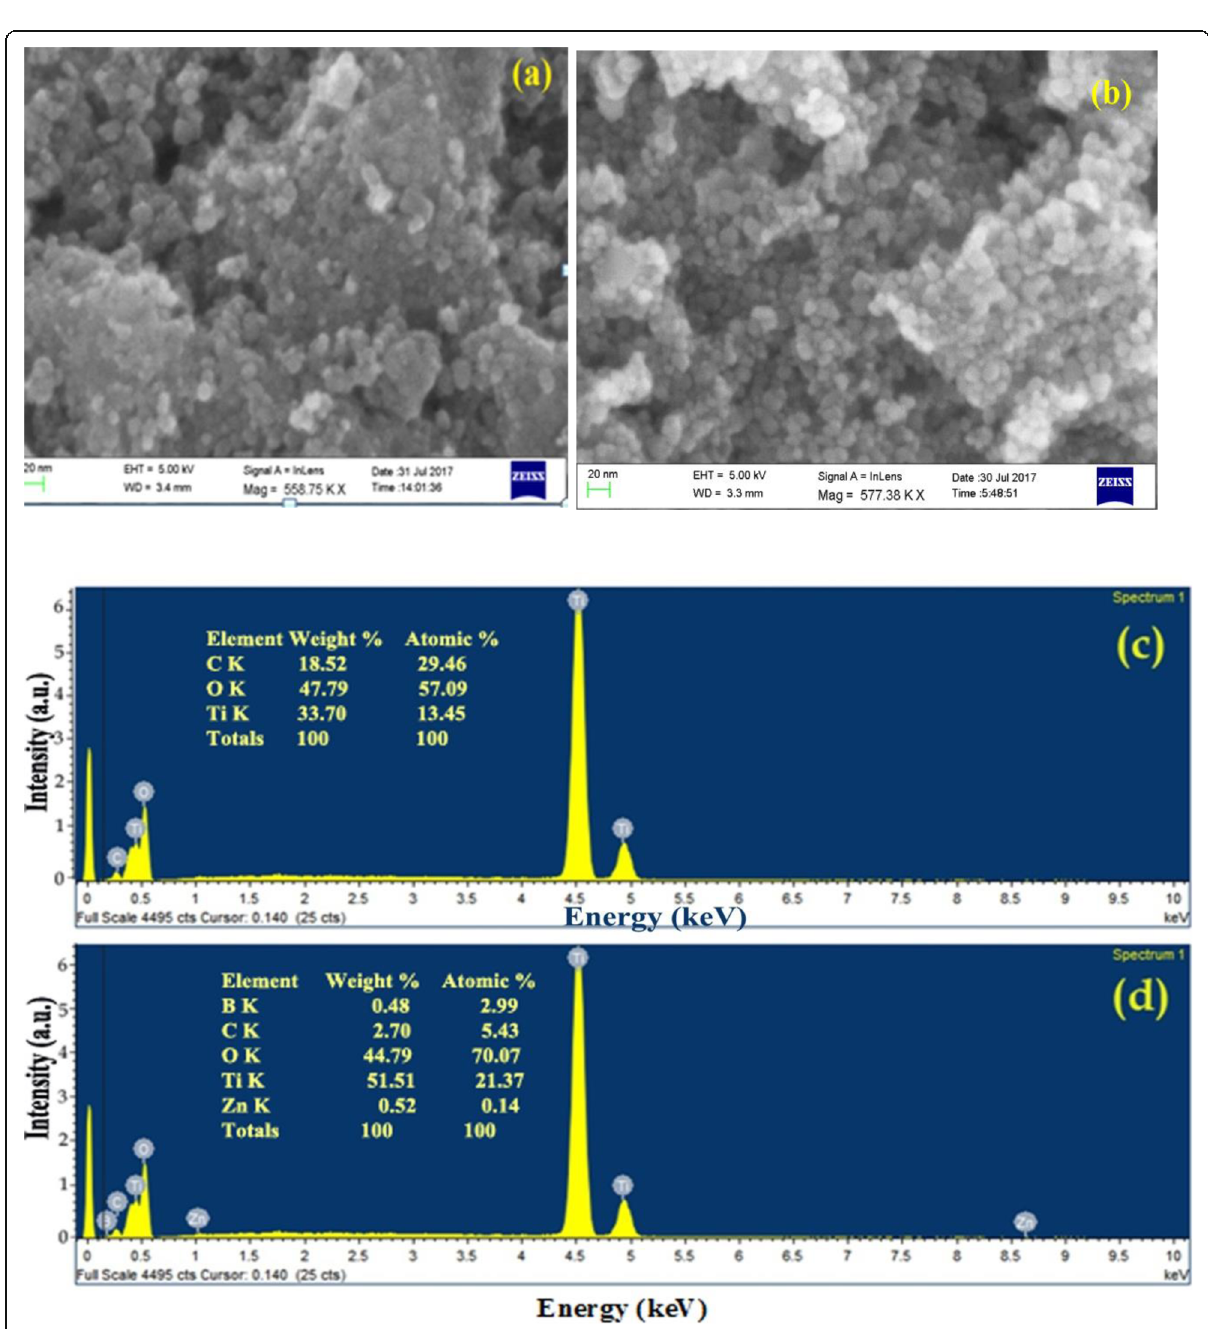
Fig. 5 FESEM images of ( a ) undoped TiO 2 , ( b ) 0.5 wt% of Zn 2+ & 0.5 wt% of B 3+ co-doped TiO 2 and EDX spectrum of ( c ) undoped TiO 2 , ( d ) 0.5 wt% of Zn 2+ & 0.5 wt% of B 3+ co-doped